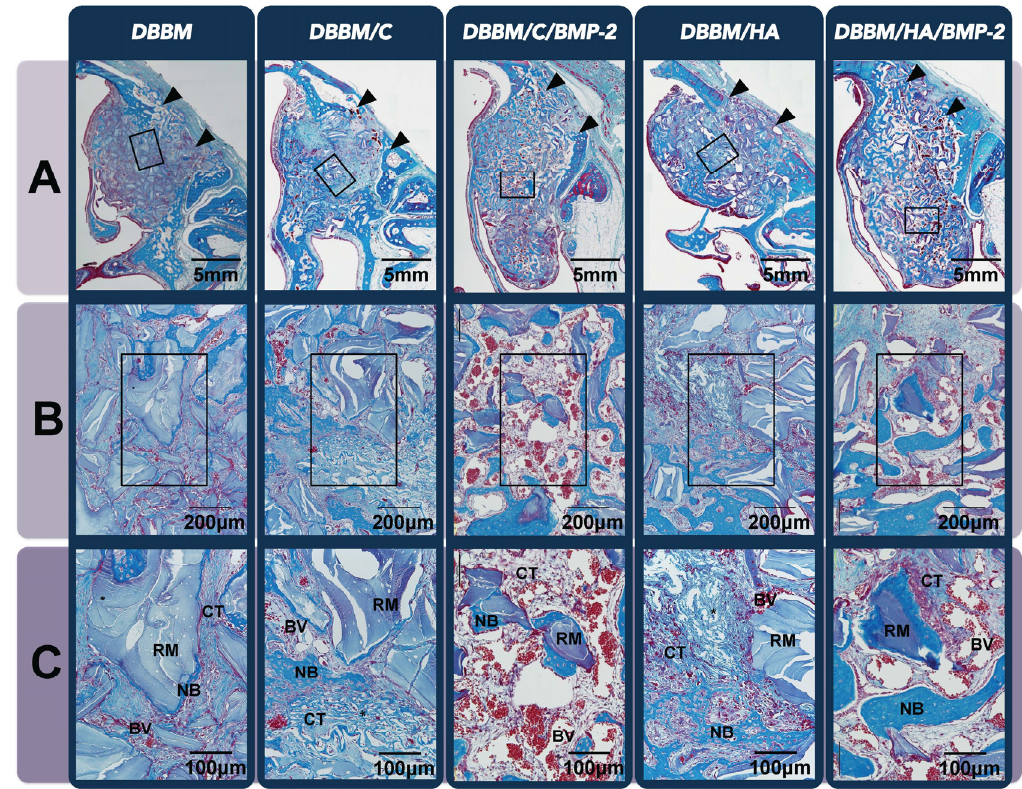
Figure 3. Histologic analysis in the rabbit sinus-augmentation model at the two-week healing point. ( A ) Low-magnification image of the entire sinus-augmentation site in each group after two weeks of healing (Masson’s trichrome staining, original magnification ×40, scale bar = 5 mm). Arrowheads indicate surgically created window sites. Newly formed bone (NB) could be observed all around the augmented area, but was concentrated locally around the grafted particles and near to the preexisting bone/Schneiderian membrane; ( B ) Representative high-magnification view (Masson’s trichrome staining, original magnification ×100, scale bar = 200 μ m). ( C ) A twofold ‐ enlarged images in the center of ( B ) (Masson’s trichrome staining, magnification, ×200, scale bar = 100 μ m). A peculiar healing pattern was observed at both experimental sites in which rhBMP-2 was grafted; a very large amount of blood vessel (BV) formation can be seen in all areas between the particles and it was significantly higher in the DBBM/C/BMP-2 group than in the DBBM/HA/BMP-2 group. Arrowheads, surgically created entrance of window opening; DBBM, deproteinized bovine bone mineral; C, absorbable collagen sponge; BMP ‐ 2, bone morphogenetic protein ‐ 2; HA, hydroxyapatite ‐ coated collagen; RM, residual material; AT, adipose tissue; CT, connective tissue.